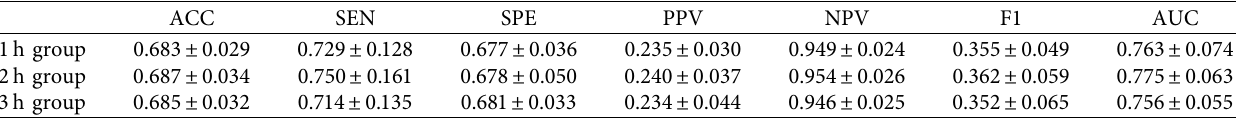
Table 2: Comparison of the models’ efects in 1 h, 2h, and 3 h groups.